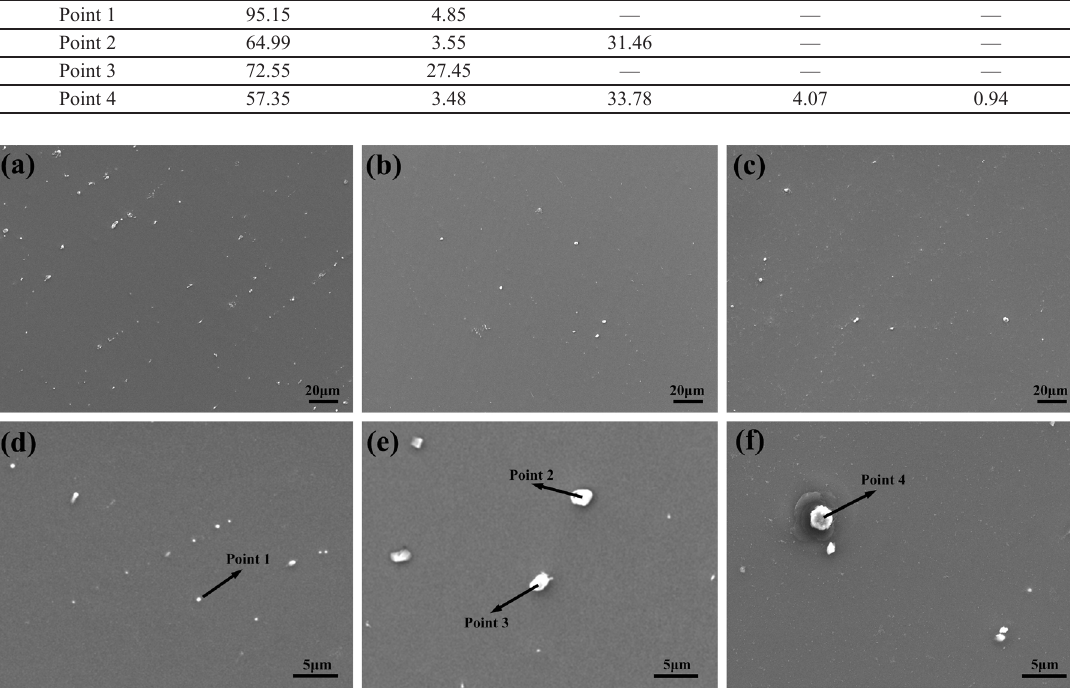
Table 2. The EDS data of the marked point in Figure 2. ( wt. %)